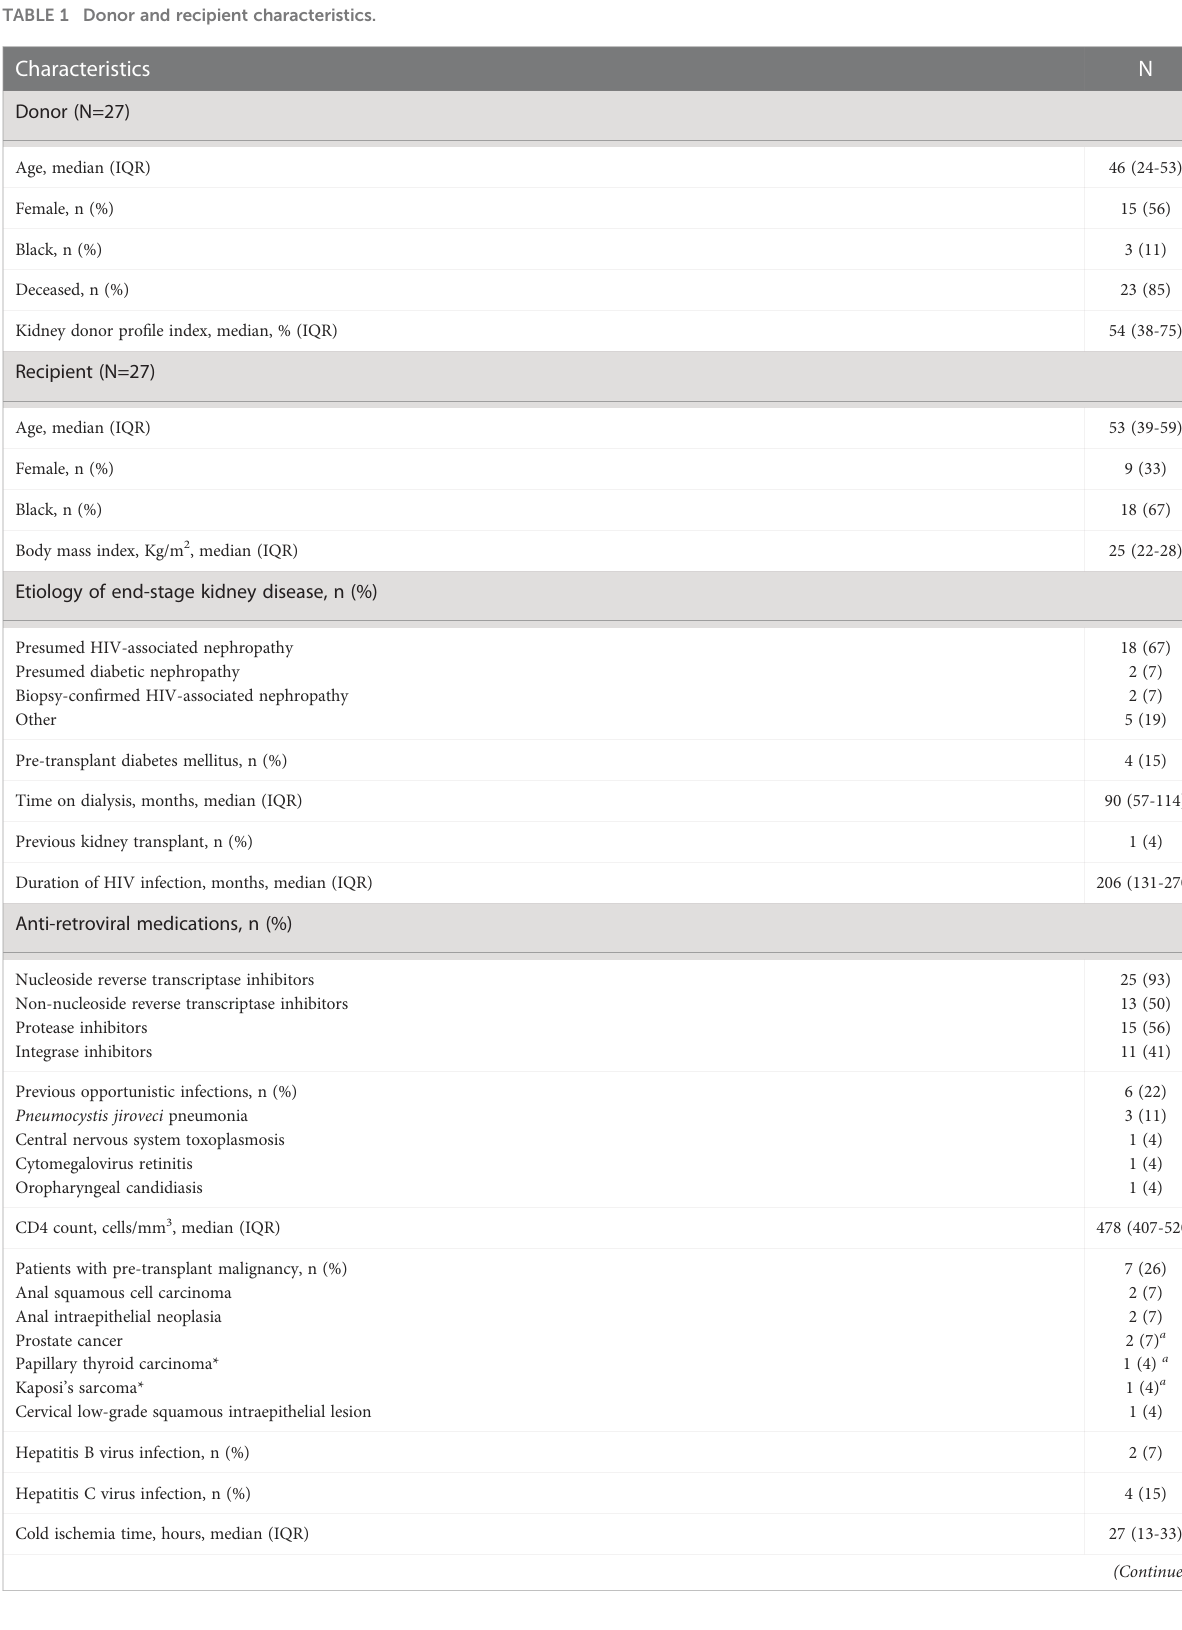
TABLE 1 Donor and recipient